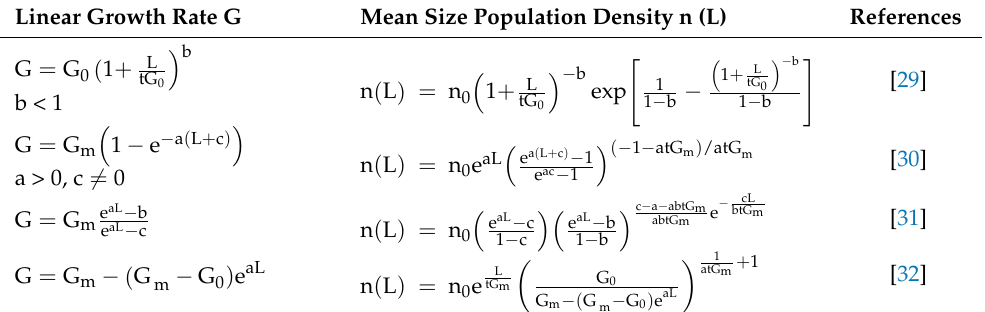
Table 1. The SDG models. Linear Growth Rate G Mean Size Population Density n (L)